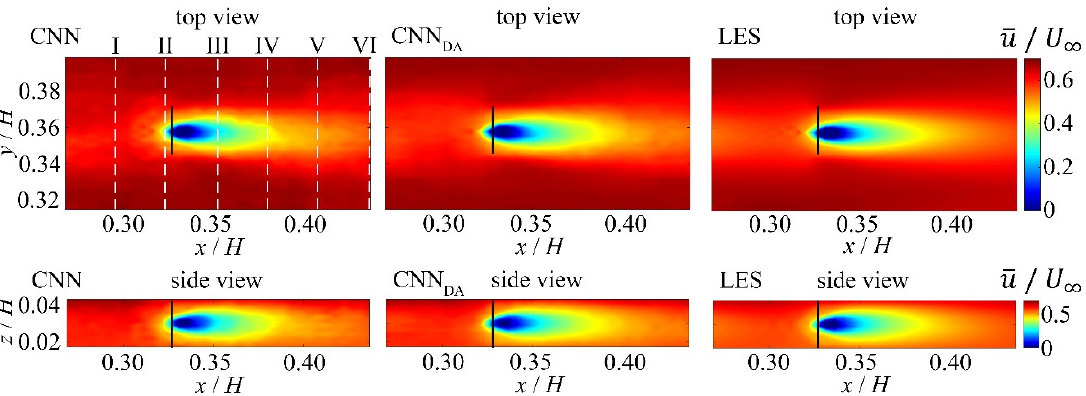
Figure 10. Mean square error as a function of the number of input snapshots; ( a ) and ( b ) present the computational errors of the CNN for the training and test dataset, respectively.